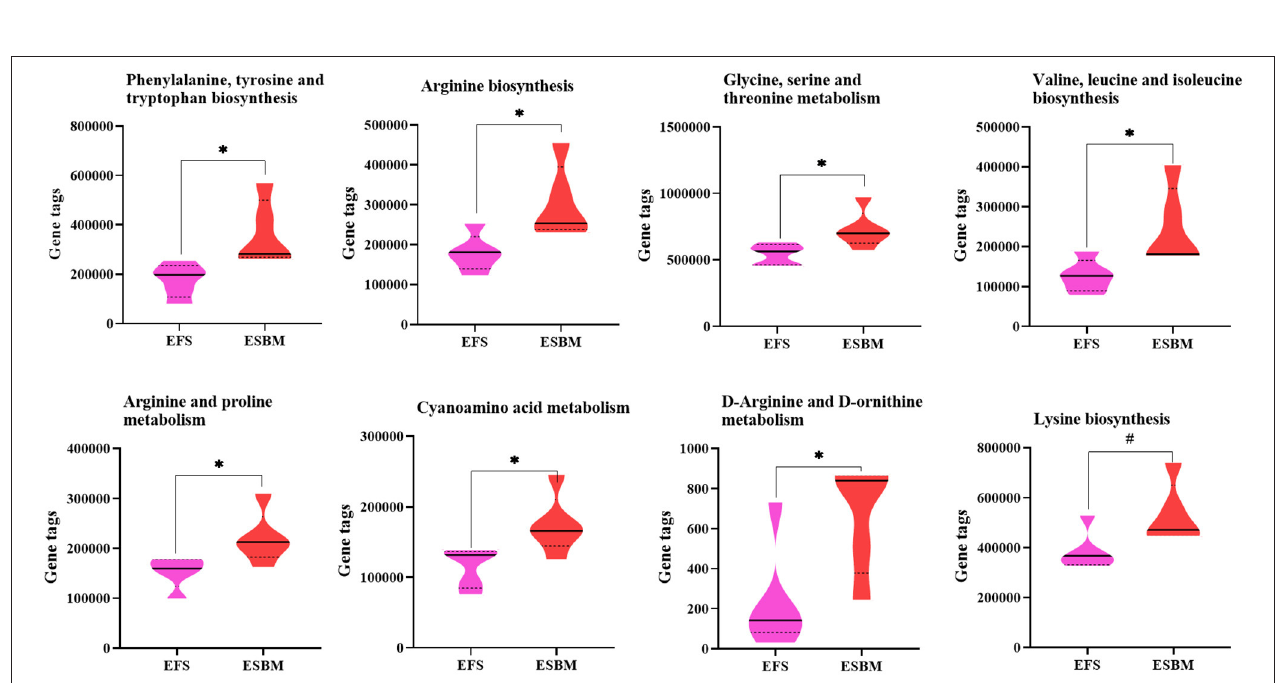
FIGURE 4 | Prediction on amino acid metabolism of bacterial communities using the PICRUSt program. The individual minipig was regarded as the experimental unit, n = 5 for EFS, n = 5 for ESBM. EFS, extruded full-fat soybean; ESBM, enzyme-treated soybean meal. * P < 0.05; # P < 0.10.